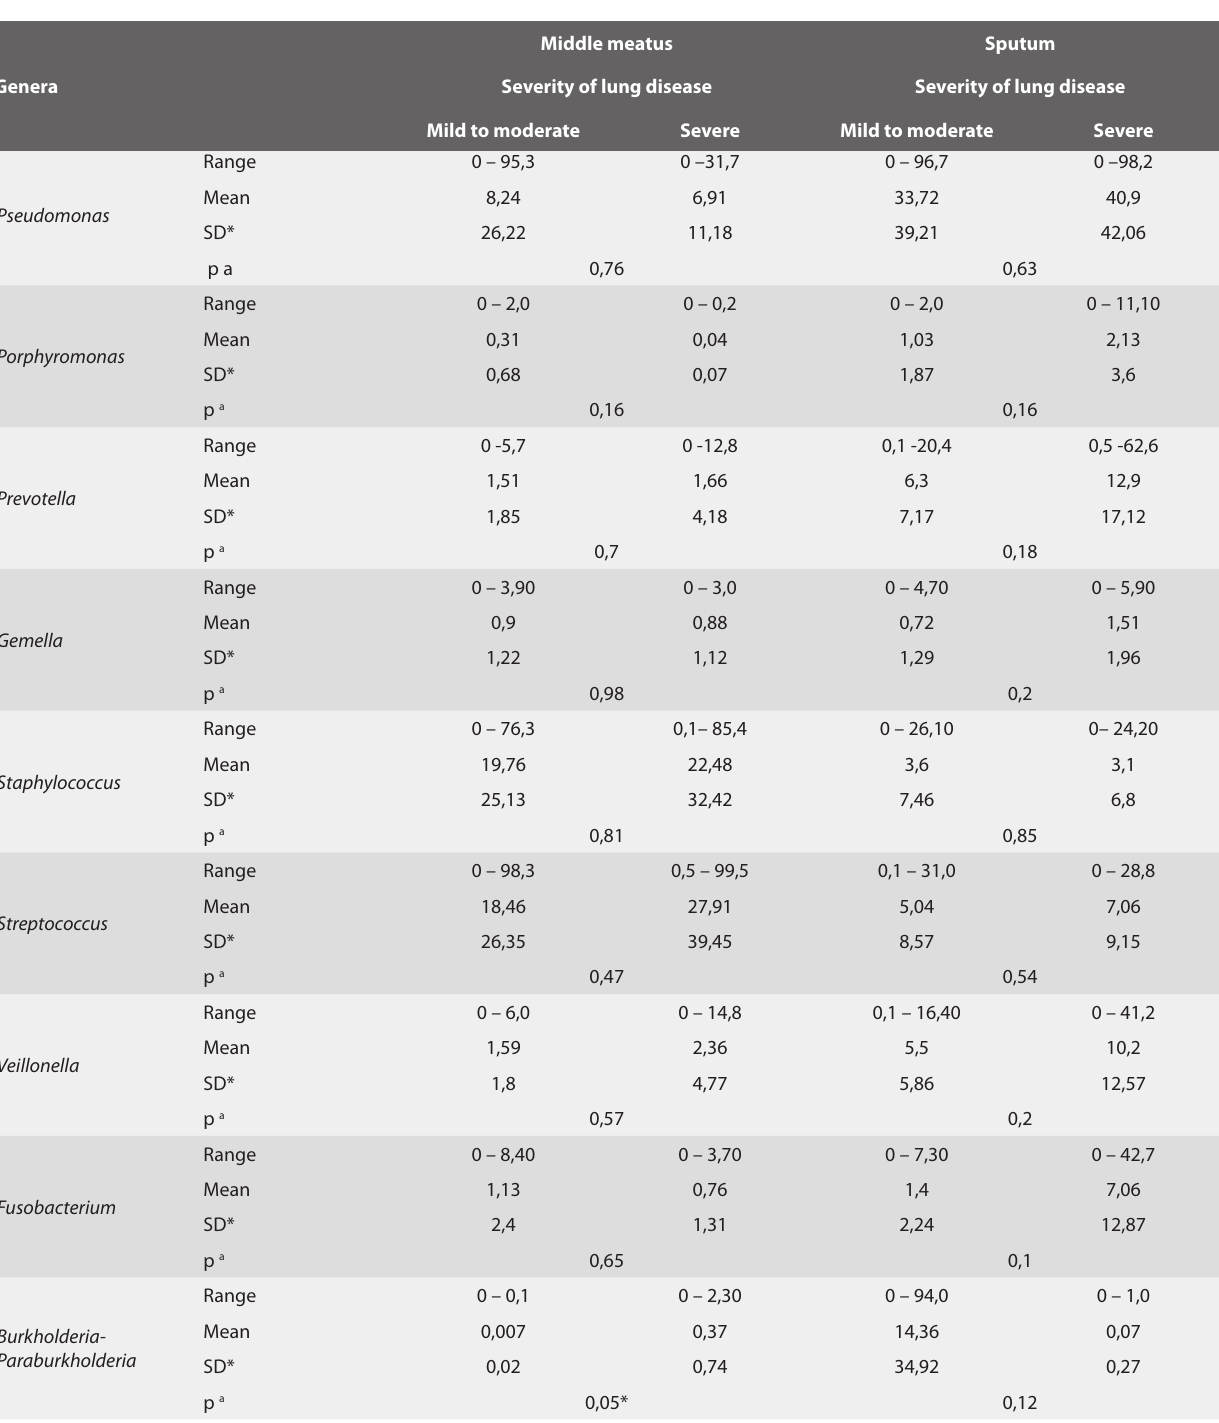
Table S1. Relative abundances of the principal genera in the middle meatus and sputum samples according to lung disease severity. The microbi- ome composition of middle meatus from patients with severe lung disease exhibited an increase of Burkholderia-Paraburkholderia , in comparison with those with mild to moderate lung disease (p=0,05). The microbiome composition of the sputum from patients with severe lung disease had a decrease of Haemophilus , compared to those with mild/moderate lung disease